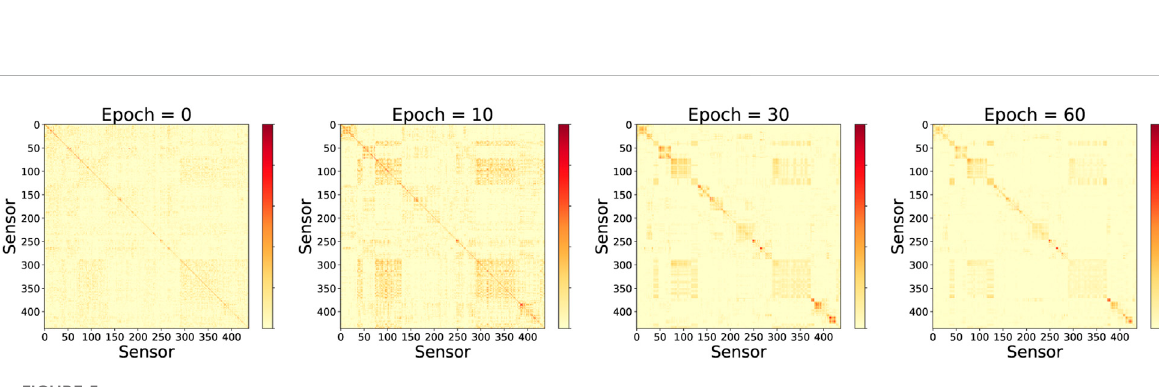
FIGURE 5 The change of adaptive adjacency matrix learned during model